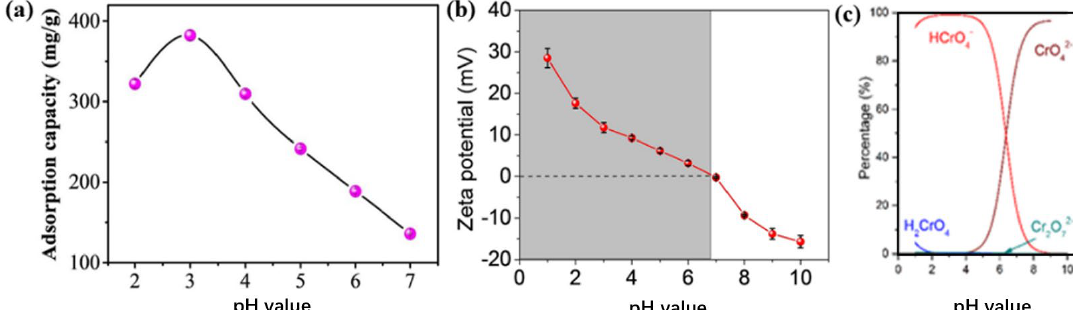
Figure 8. ( a ) The effect of the pH value of the Cr (VI) aqueous solution on the adsorption capacity of PAN/GO porous nanofibers; ( b ) zeta potential of porous PAN/GO nanofibers in aqueous solutions with different pH values; ( c ) The form of Cr (VI) at pH from stepwise from 1–10. Reprinted with permission from ref. [54]. Copyright 2020 Elsevier. Table 1. The adsorption performance of other nanofiber adsorbents for heavy metal ions.